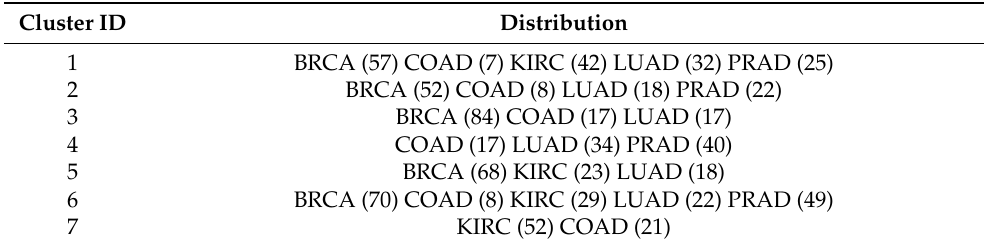
Table 4. The distribution of the hierarchical cluster assignments using complete linkage (default settings in R are used) and the gap statistic to select the number of clusters. The gap statistic suggests 7 clusters.